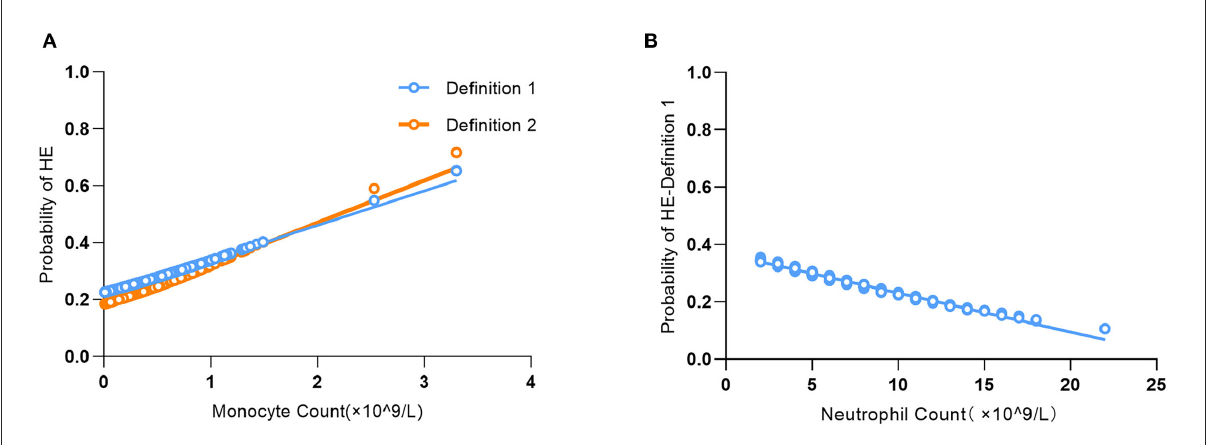
FIGURE2 Association of monocyte count (A) and neutrophil count (B) with the probability of predicting hematoma expansion (HE).